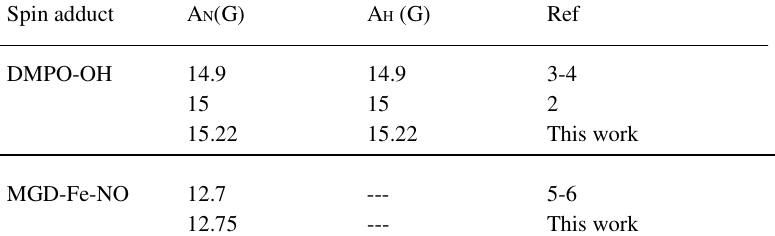
Figure 4 . EPR spectra of NO trapping using Fe–MGD: (A) Experimental spectrum; (B) Simulated spectrum . The hyperfine coupling constant is provided in the Table 1. Table 1 . EPR hyperfine coupling constants of DMPO-OH and MGD-Fe-NO adducts Spin